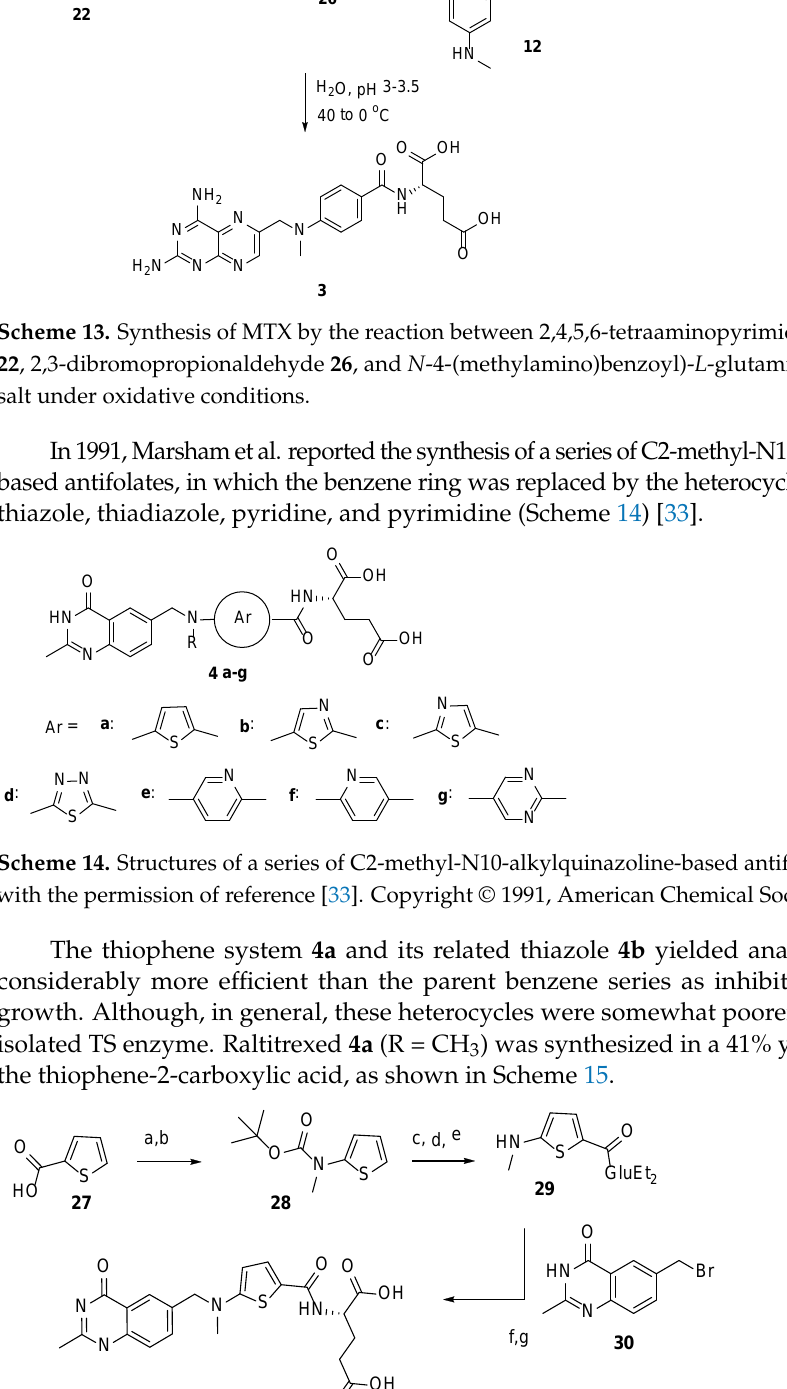
Scheme 13. Synthesis of MTX by the reaction between 2,4,5,6-tetraaminopyrimidine hydrosulphate 22 , 2,3-dibromopropionaldehyde 26 , and N -4-(methylamino)benzoyl)- L -glutamic acid 12 disodium salt under oxidative conditions.